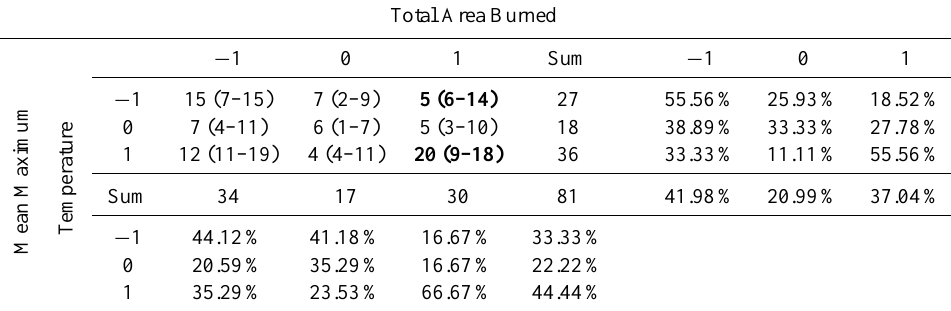
Table 2. Cross-tabulation results between burned area and mean maximum air temperature. Monte Carlo randomization confidence limits are noted in parentheses. Values in bold are statistically